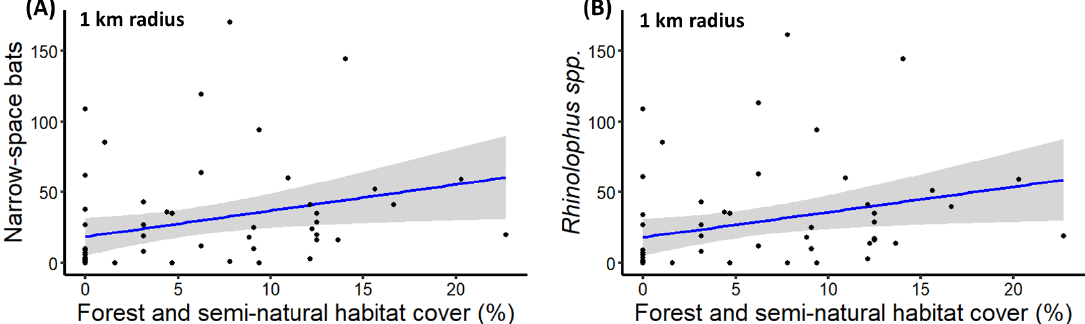
Figure 7. Effects of significant landscape factors on narrow-space foraging bats. Percentage of forest and seminatural habitat cover within a 1 km radius had a significant positive effect on the activity of narrow-space foraging bats ( A ) and Rhinolophus spp. ( B ). All regressions are plotted with 95% confidence intervals.